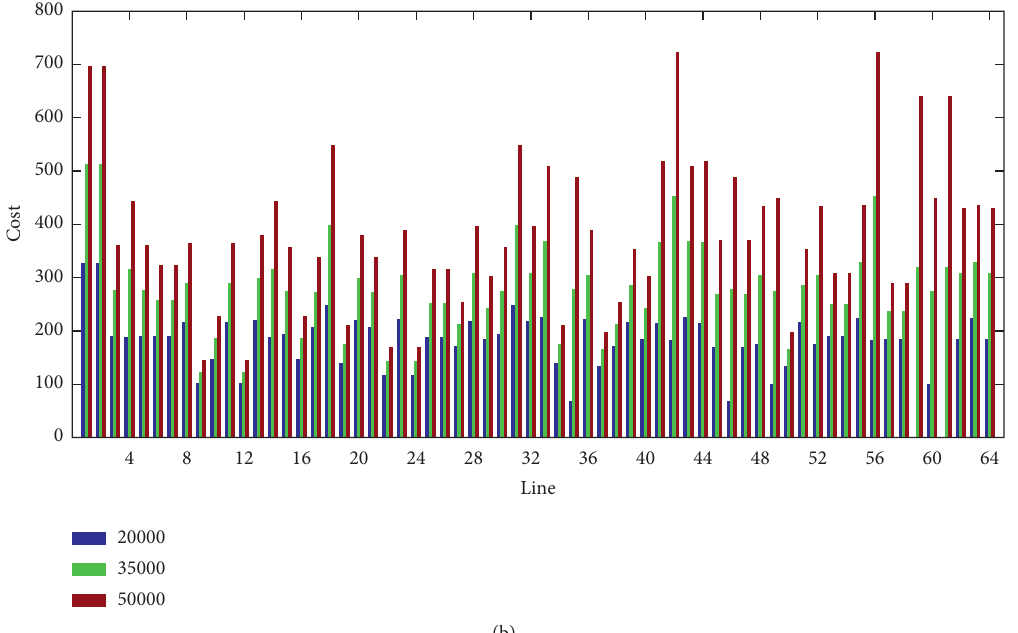
Figure 5: Illustration of the optimal cost allocation scheme. (a) Optimal cost allocation scheme for all the stations. (b) Optimal cost allocation scheme among all lines.